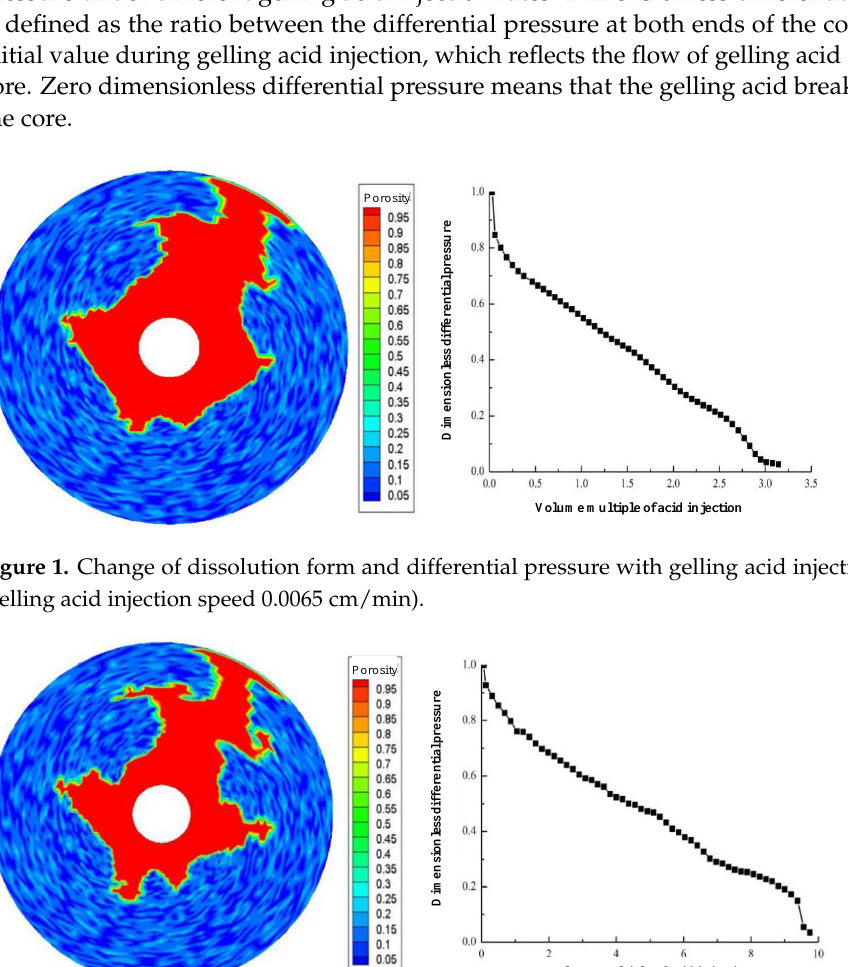
Figure 3. Change of dissolution form and differential pressure with gelling acid injection (gelling acid injection speed 0.035 cm/min).